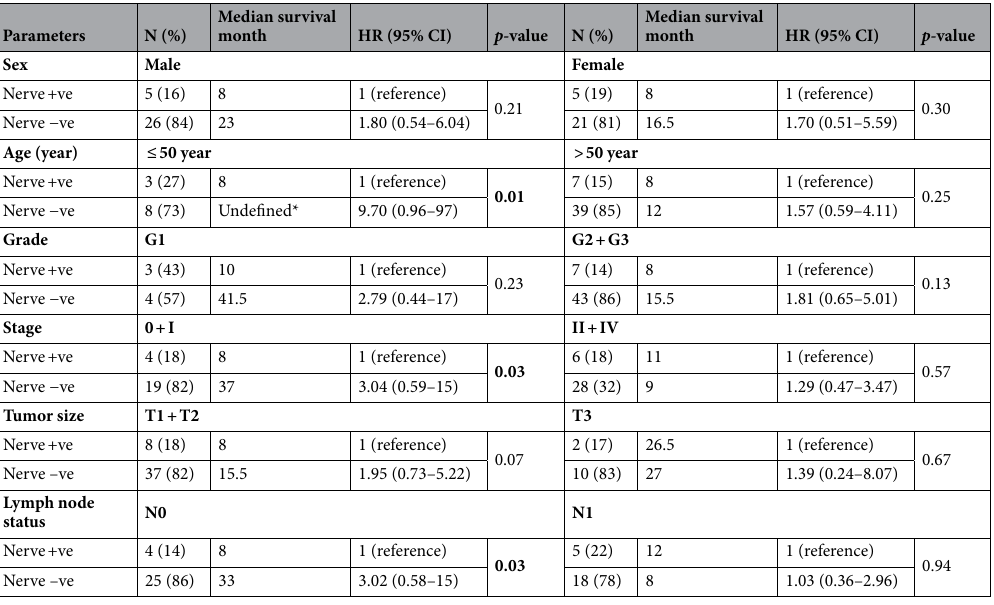
Table 3. Association between nerve infiltration and clinicopathological characteristics. Patients with different clinicopathological parameters were stratified as positive or negative for the presence of nerve infiltration to assess the association of nerve infiltration with clinicopathological parameters in PC. HR hazard ratio, CI confidence interval. p -values were calculated by the log-rank test. Values in bold indicate significance ( p < 0.05). Star sign (*) denotes if more than 50% of the subjects are alive at the end of the study, then the median survival time is simply not defined/undefined. HR was calculated using univariate Mantel–Haenszel hazard model.